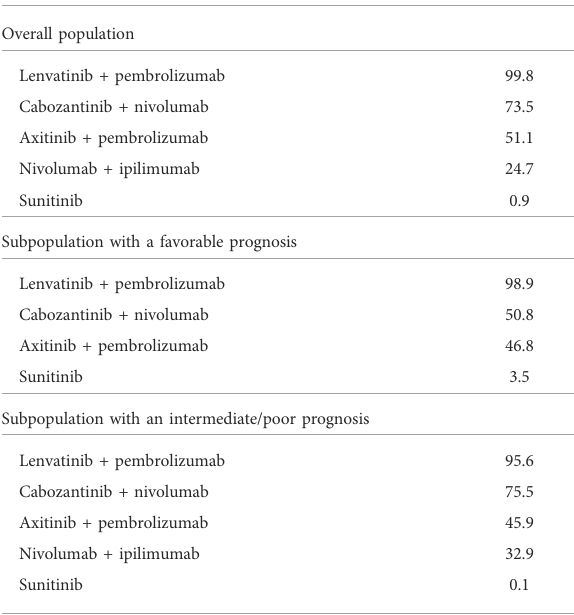
TABLE 8 The likelihood of being the preferred treatment option compared to the other treatment strategies probability of being the best treatment (SUCRA) in terms of progression-free